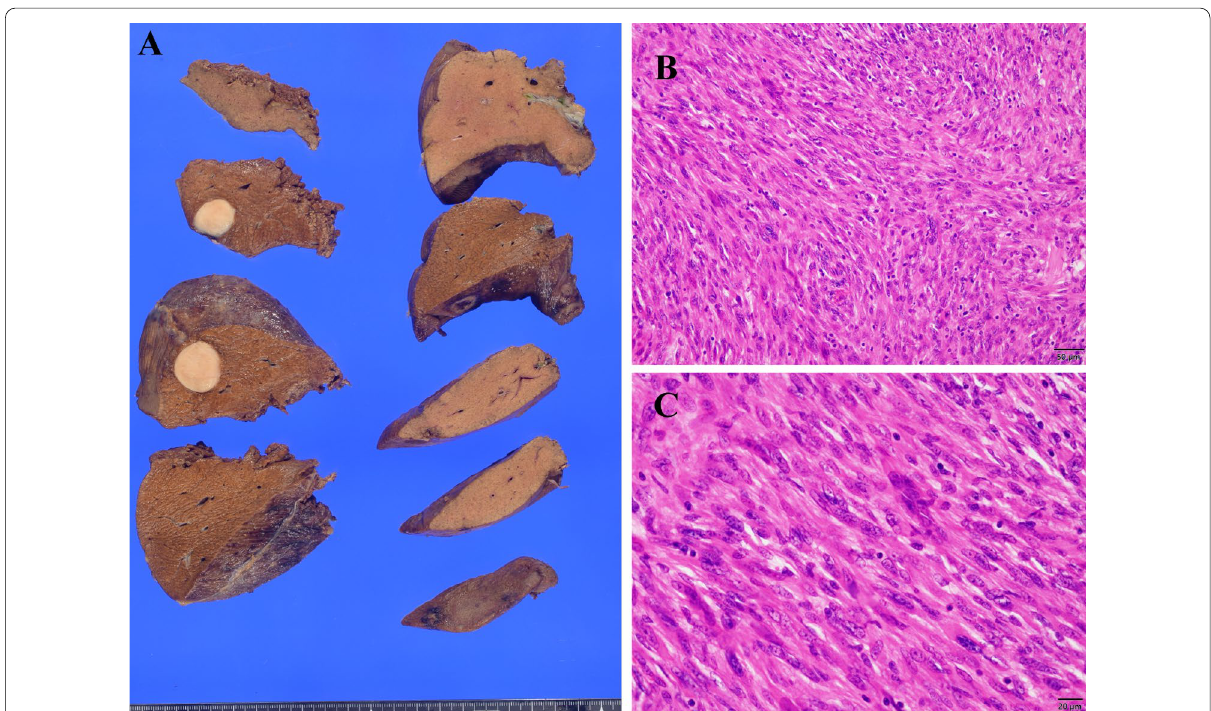
Fig. 3 A Macroscopic findings of liver metastasis of the leiomyosarcoma. A well circumscribed solitary mass is seen, measuring 21 B, C Microscopically, the morphology is similar to that of the primary tumor ( B HE staining, original magnification magnification 400) ×